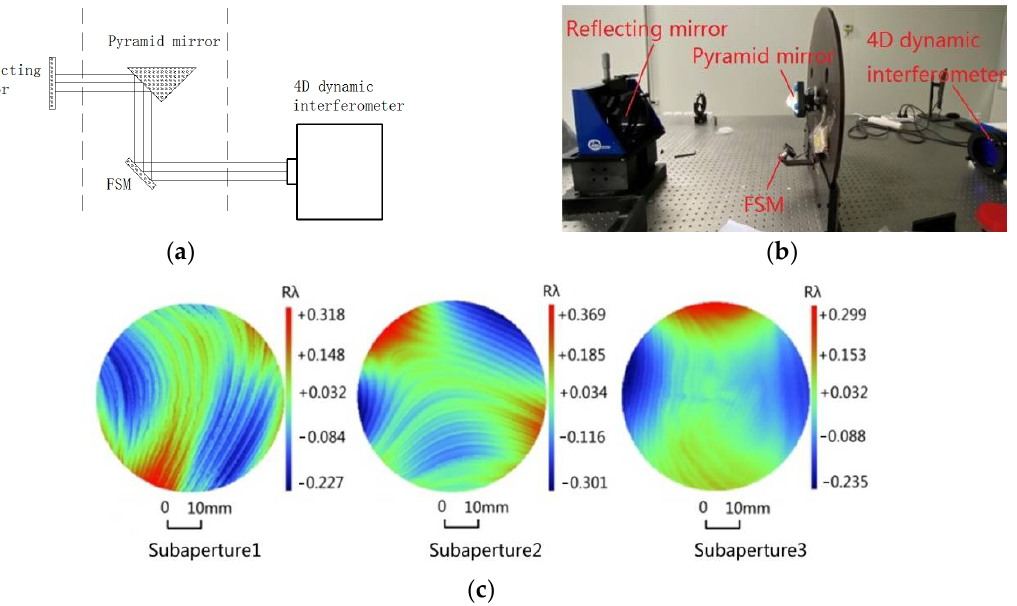
Figure 16. Interferometric testing: ( a ) the principle, ( b ) the alignment process, and ( c ) alignment results displayed in the interferometer through PZT precision adjustment.